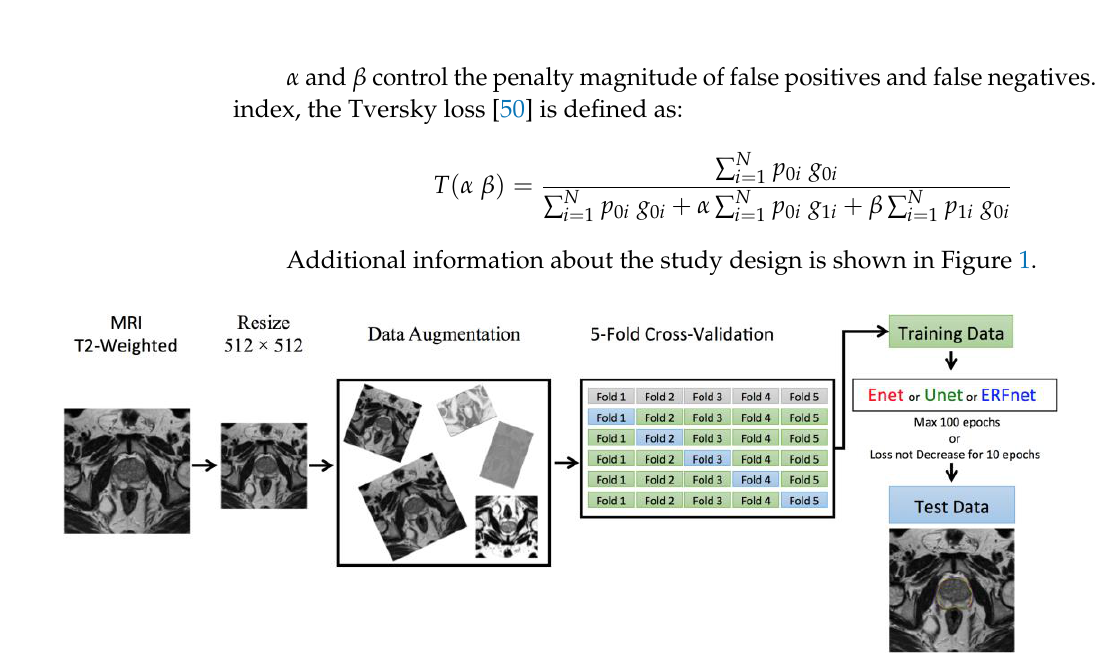
Table 2. The model parameters and shape output after the first hidden layer in the ENet model for a given provided input image (Patient #7 slice #20).